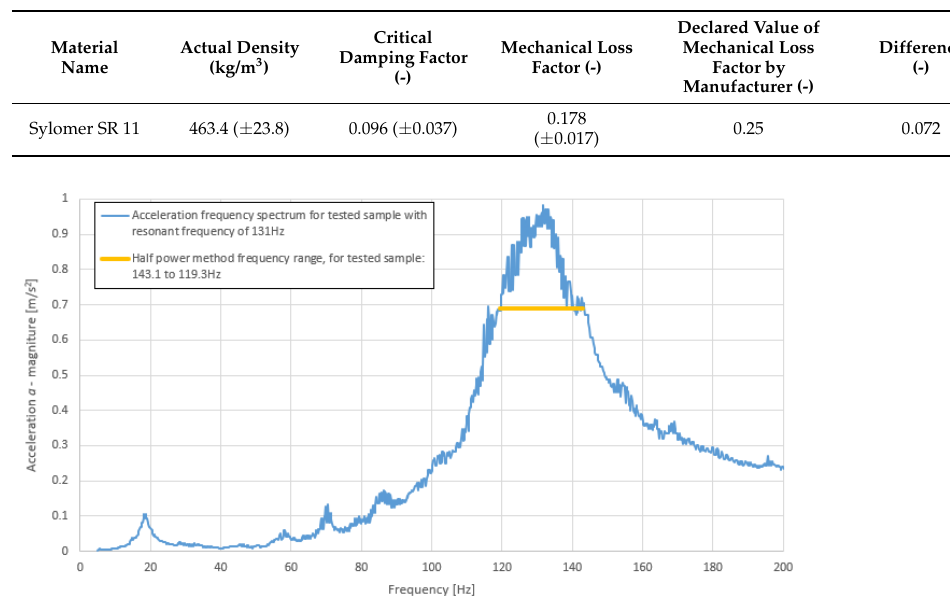
Table 6. Results of measurement of dynamic stiffness of tested samples of Sylomer SR 11 12.5 mm (17 samples).